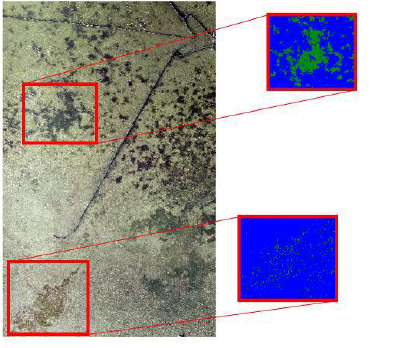
Figure 4: Comparison of Stitched and Classified Stitched Image The Regions of Interest (ROIs) were created in order to classify which are train datasets and the other half are check datasets.